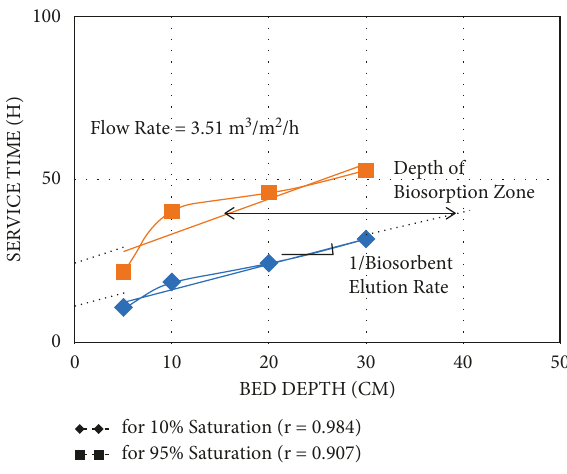
Figure 6: Effect of flow rate. Figure 7: Bed depth service